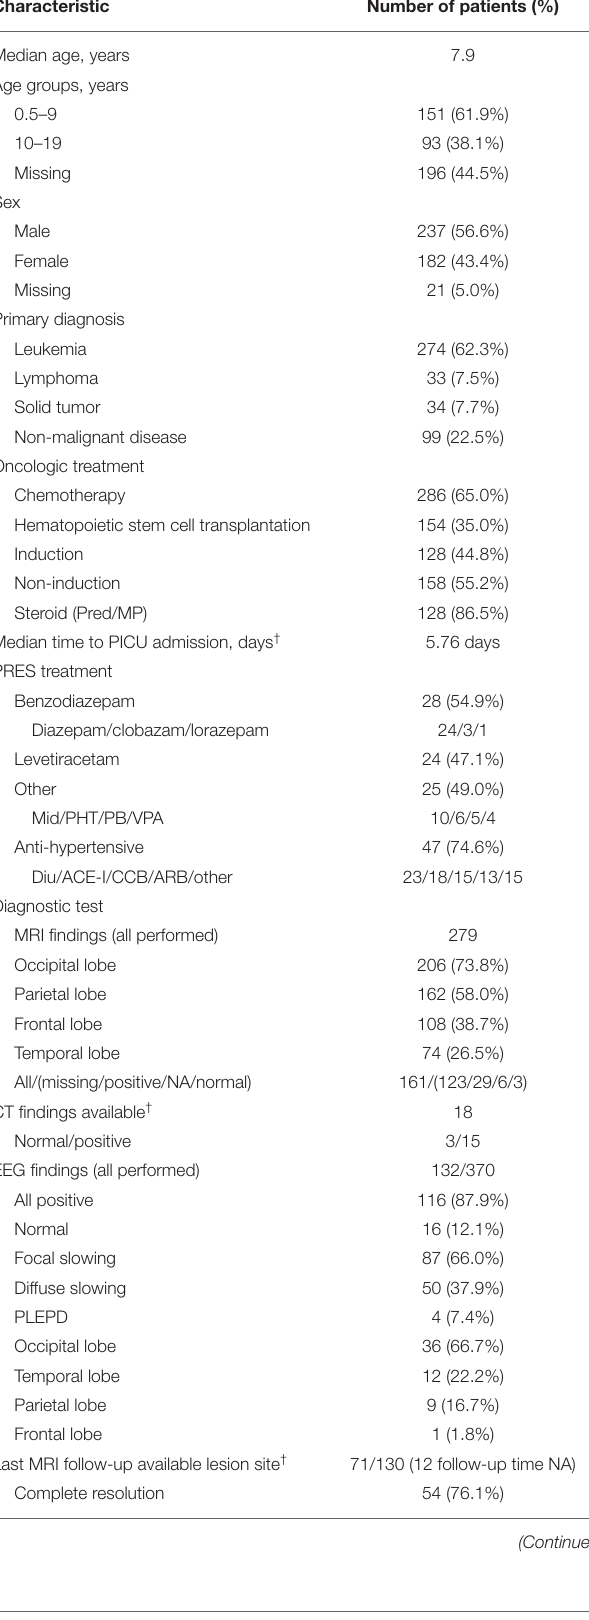
TABLE 3 | Demographic and clinical characteristics and outcomes of PRES patients with pediatric oncologic/hematologic diseases.